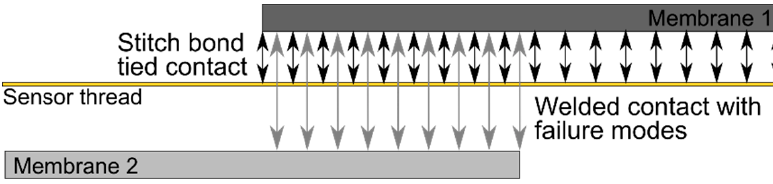
Figure 6. Contact situation in the membrane model with integrated sensor.